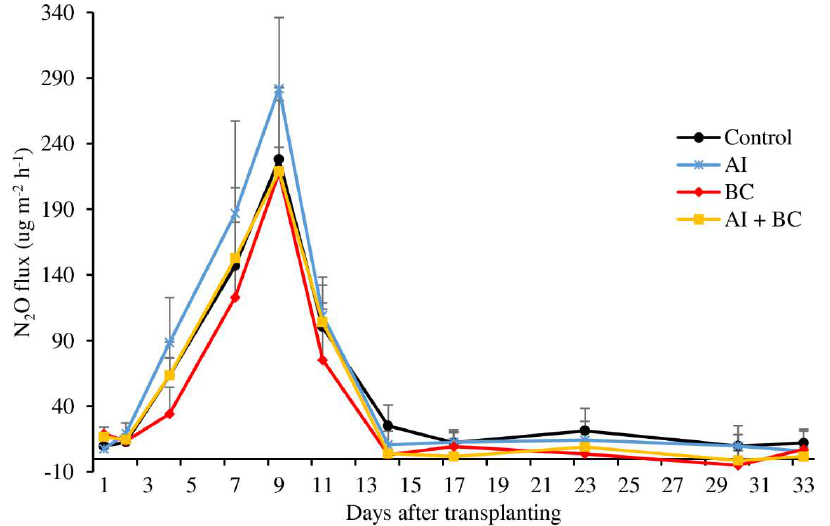
Figure 2. Soil N 2 O emissions affected by aerated irrigation (AI) and/or biochar (BC) during the growing period of komatsuna. Error bars indicate standard deviation ( n = 3).